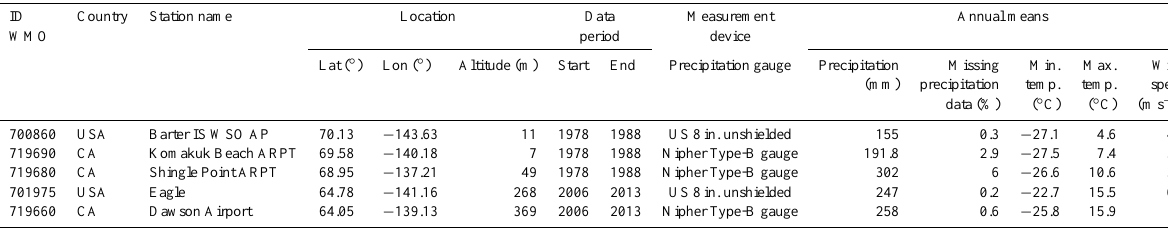
Table 1. Station information and climate summary.